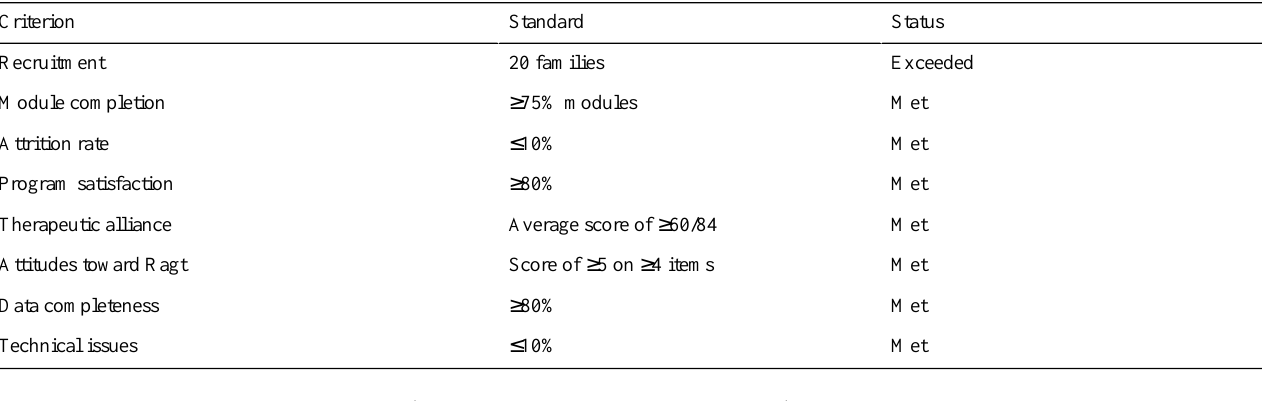
Figure 5. Family Teamwork Online CONSORT (Consolidated Standards of Reporting Trials)